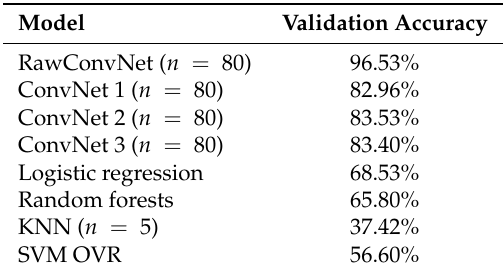
Table 19. Performance summary of raw audio ConvNets and ML models on BUZZ2 validation